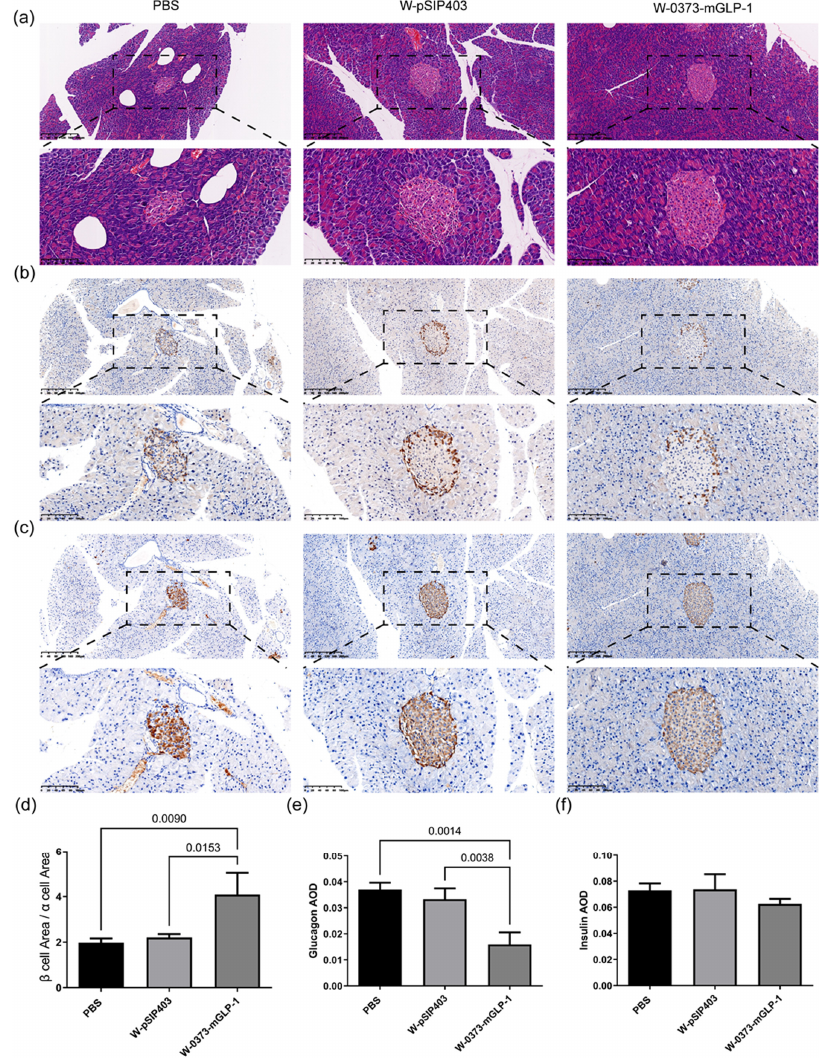
Figure 8. Effects of 14-day W-0373-mGLP-1 administration on pancreatic histomorphology, glucagon and insulin. Scale bar 20 µ m (20 × magnification). ( a , d ) Hematoxylin and eosin (H&E) staining of pancreas in db/db mice and corresponding ratio of β cells to α cells; ( b , e ) Immunohistochemistry (IHC) staining and quantitative average optical density (AOD) analysis of glucagon in pancreas; ( c , f ) IHC staining and quantitative AOD analysis of insulin in pancreas. All data are represented as mean ± SD.